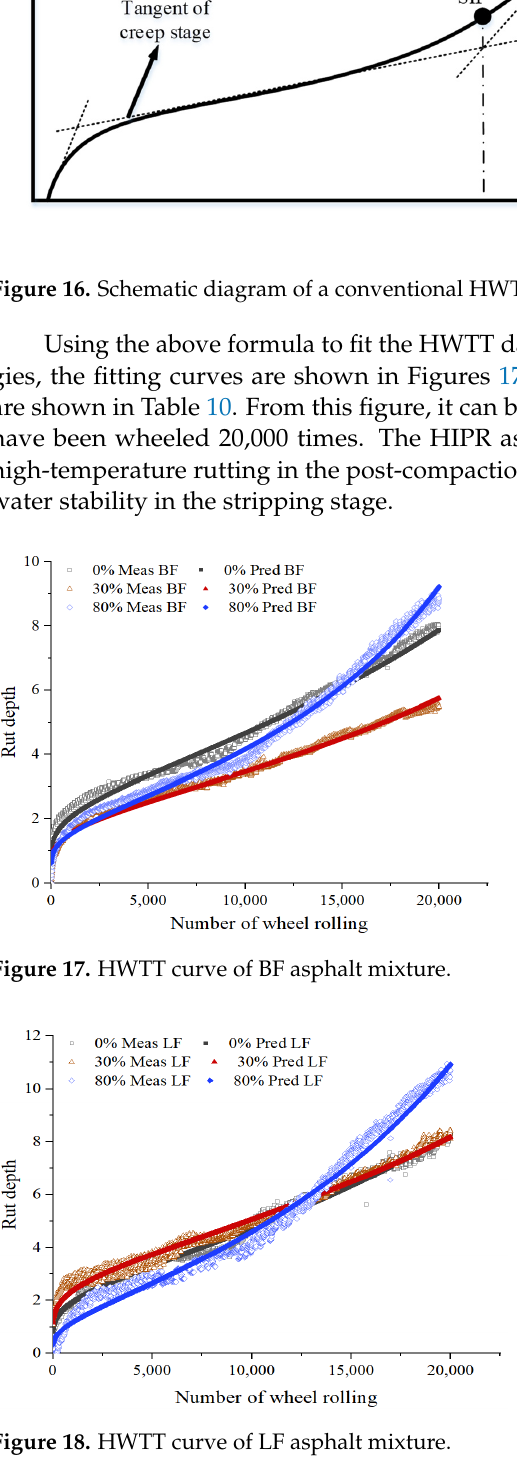
Figure 16. Schematic diagram of a conventional HWTT curve.